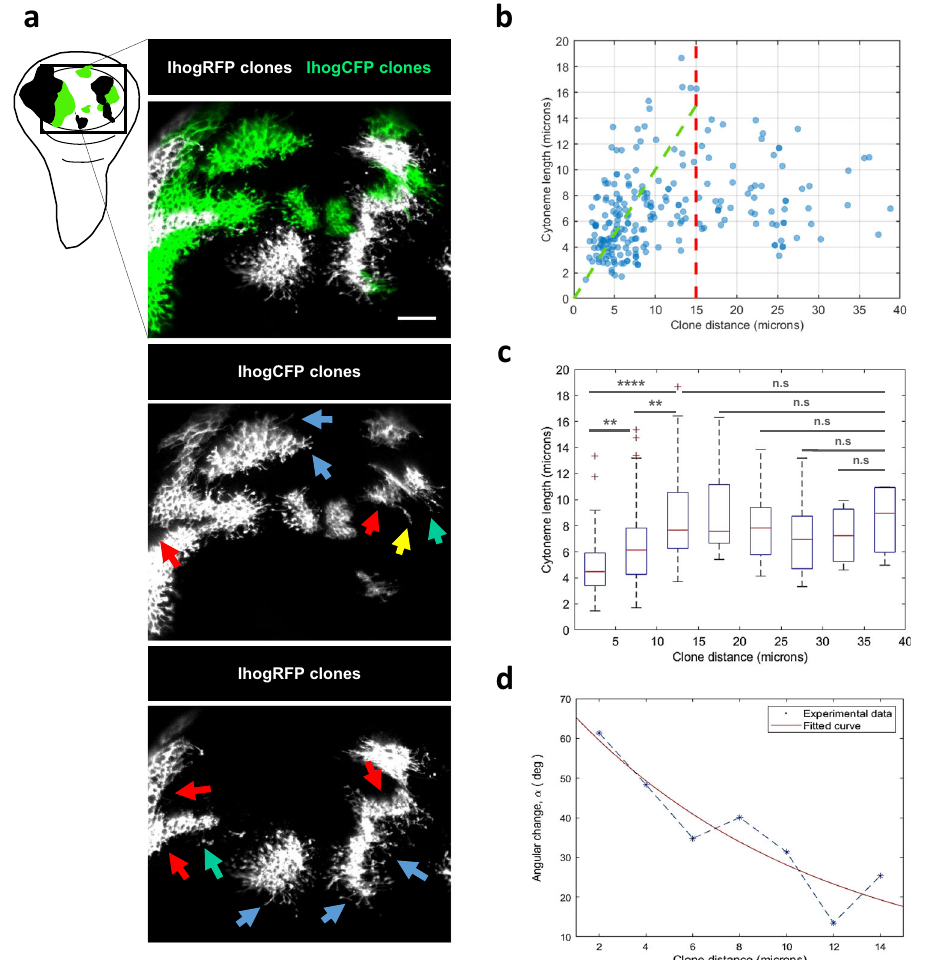
Fig. 2 | Cytoneme behavior depends on the distance to the Ihog source. a Ihog overexpression clones marked with different fl uorophores. Blue arrows point to cytonemes stabilized towards areas without clones; red arrows point to touching clones showing no cytoneme stabilization whenconfronted;greenarrowspointto stabilized cytonemes crossing small clones (<2 cell diameters); <18% of the touching clones presented cytoneme stabilization (yellow arrows) for large clones (>2 cell diameters). b Cytoneme length (y-axis) versus distance between clones (x- axis) in μ m. The red dotted line indicates the distances where the data cloud has a different behavior (<15 μ m); the green dotted line represents the linear relation between the length of stabilized cytoneme and the distance between clones at shortdistances. c StatisticalstudieswasperformedusingaWilcoxonranksumtest